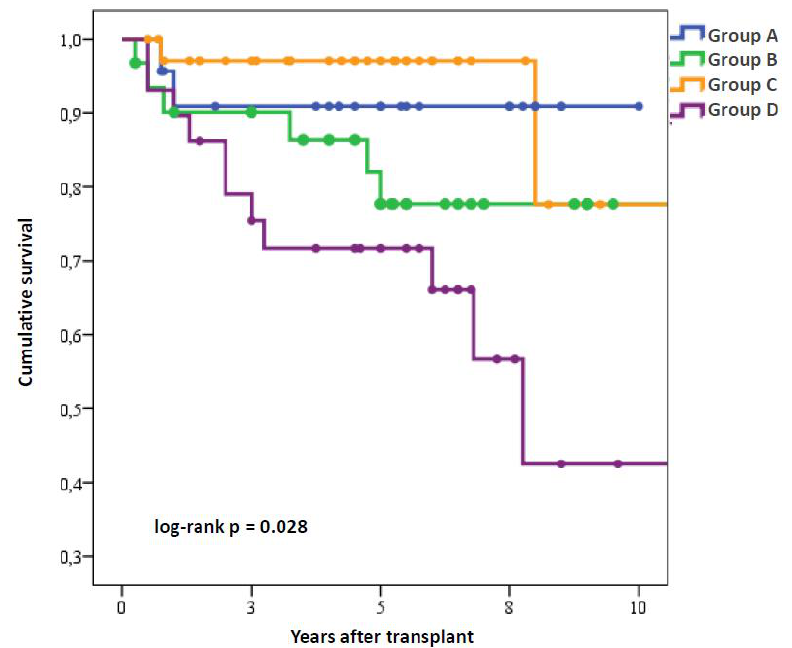
Figure 3. Kaplan-Meier survival curves of patients belonging to the 4 study subgroups: Group A: worsened, including PTDM (N = 23); group B: improved (N = 31); group C: persistently normal glucose metabolism (N = 36); group D: unchanged pre-diabetes/DM (N = 29).